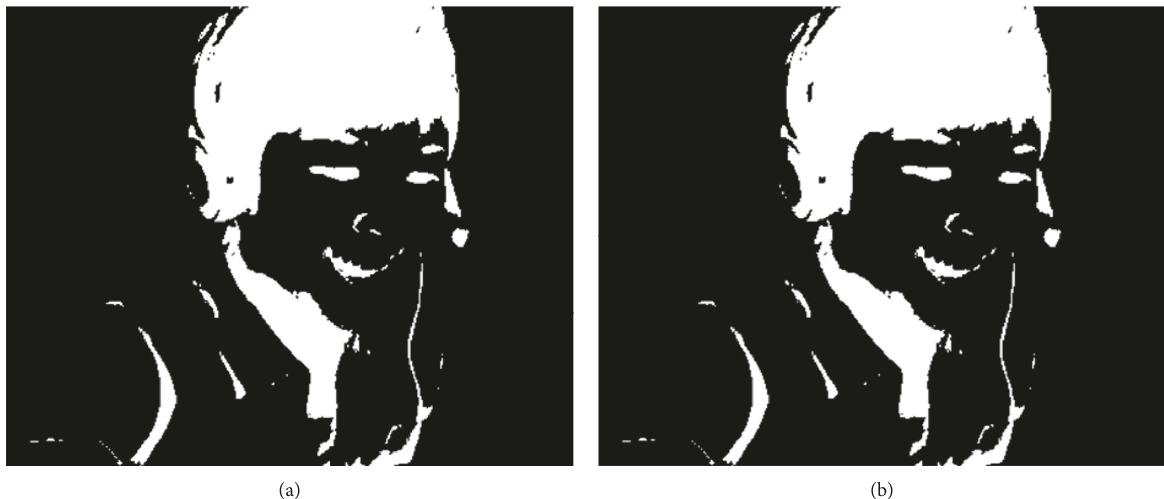
Figure 2: Simulation demodulation results. (a) The proposed method. (b) GS method. Recommendation algorithm for personalized teaching resources based on time effect